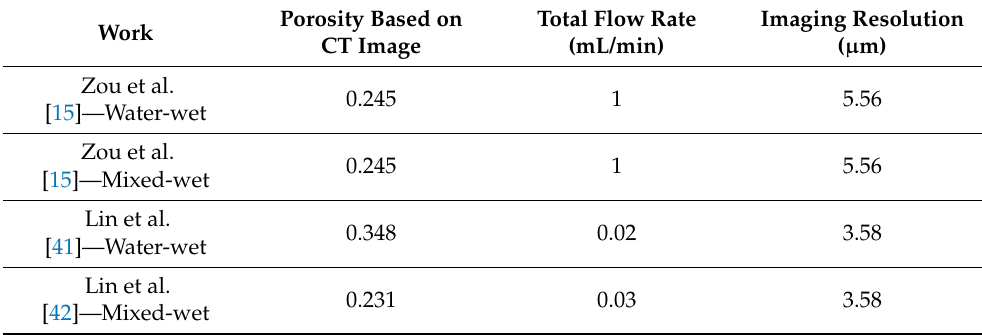
Table 1. Summary of two-phase imaging experiments conducted under in situ imaging condition flow between this work and previous works for water-wet and altered-wet